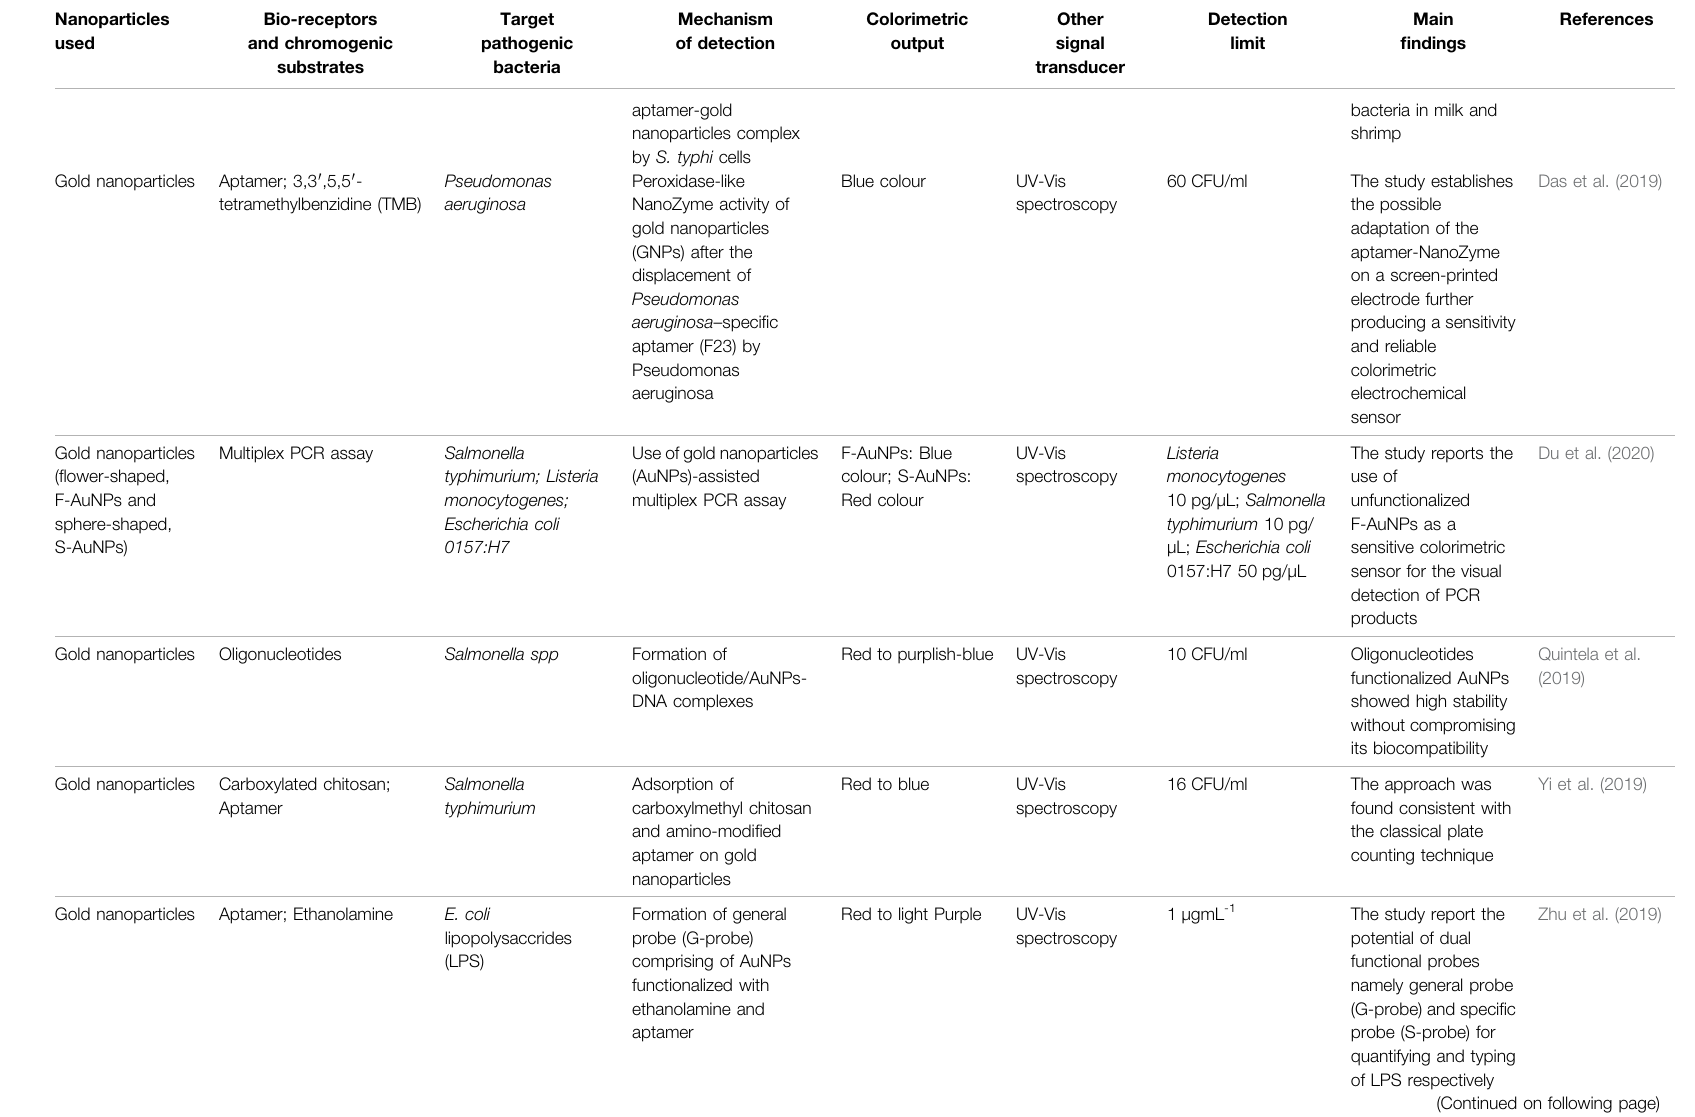
TABLE 2 | ( Continued ) Summary of studies that have applied bio-receptors and chromogenic substrates for the detection of pathogenic